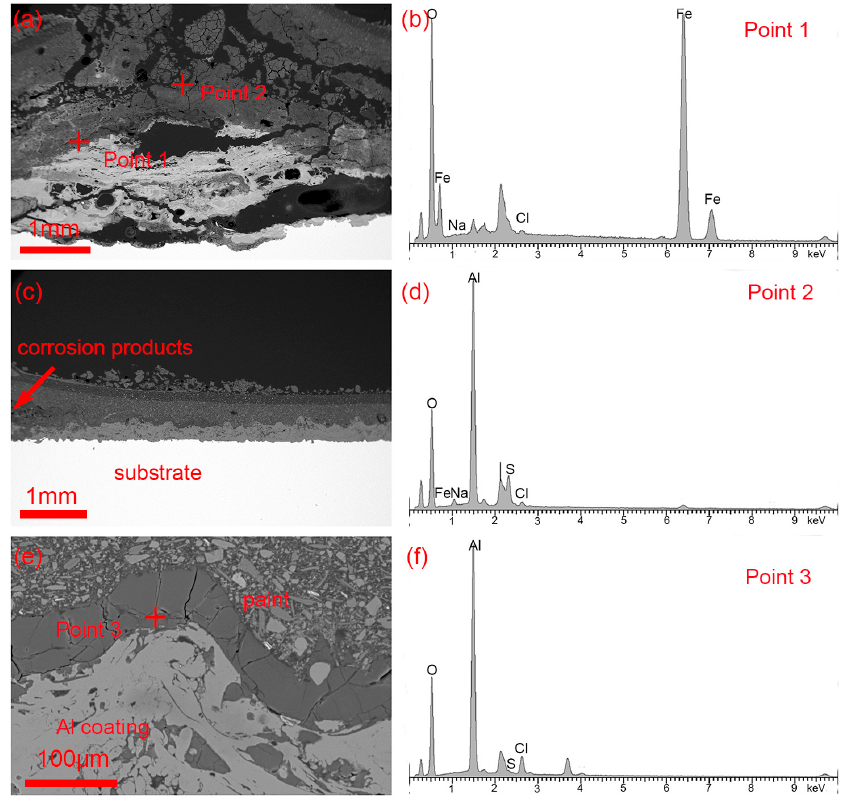
Figure 4. ( a , c , e ) SEM images of paint samples with scribed lines after 3 months of salt spray test. Some EDS patterns obtained from the region of interest are shown in ( b , d , f ).